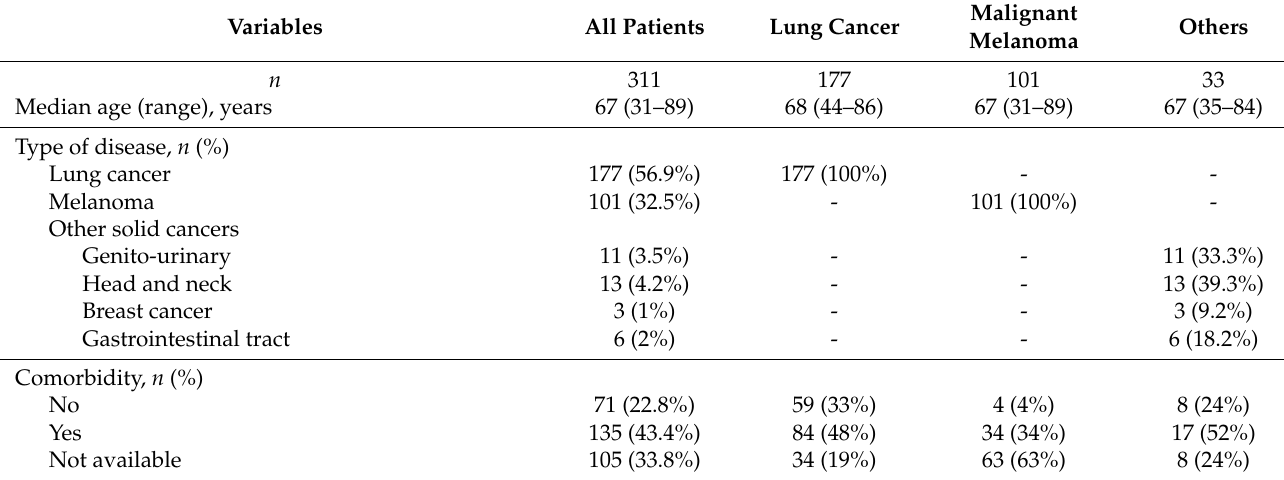
Figure 1. Flowchart for the selection of the final population. Table 1. Characteristics of patient population .